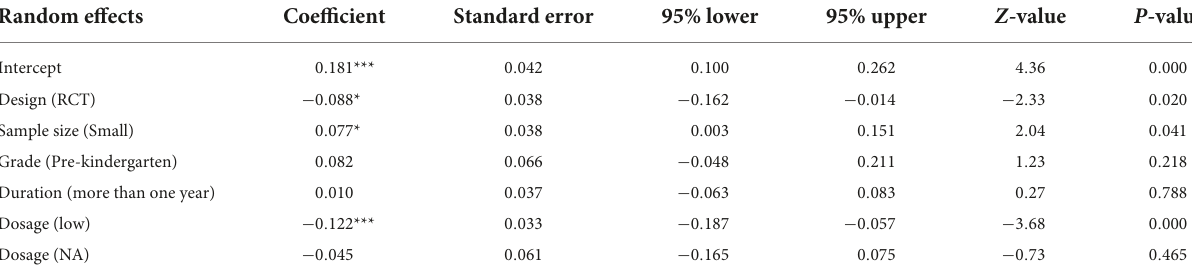
TABLE 4 Meta-regression for overall